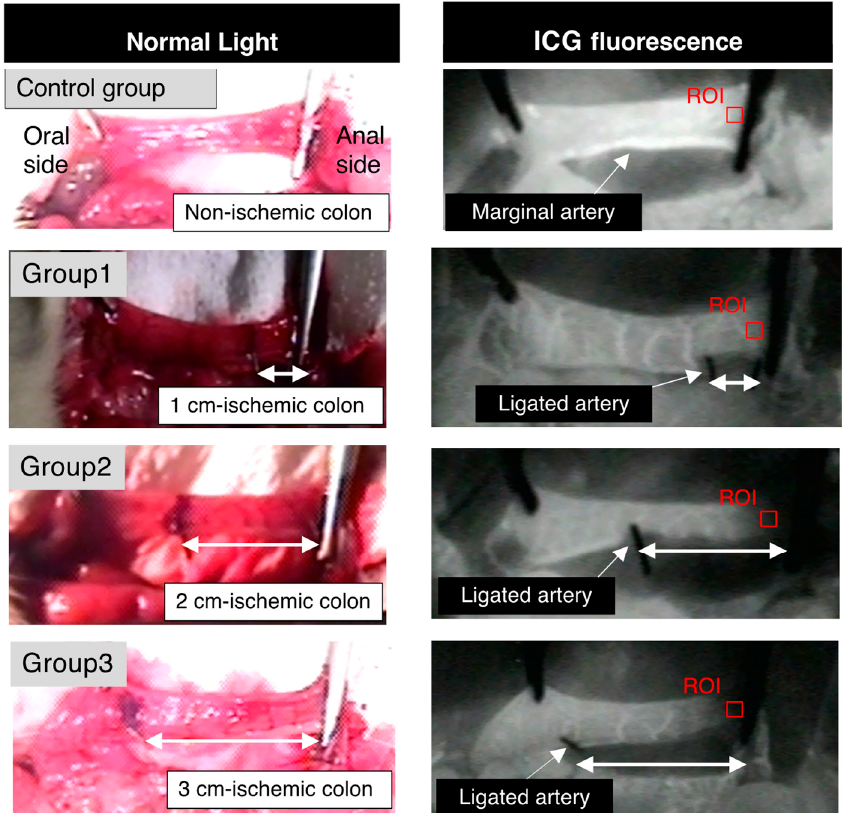
Figure 2. Non-ischemic colon group (Control Group), 1 cm-long ischemic colon group (Group 1), 2 cm-long ischemic colon group (Group 2), and 3 cm-long ischemic colon group (Group 3). ICG fluorescence was measured at the distal end of the pedicled segment (red square; region of interest).